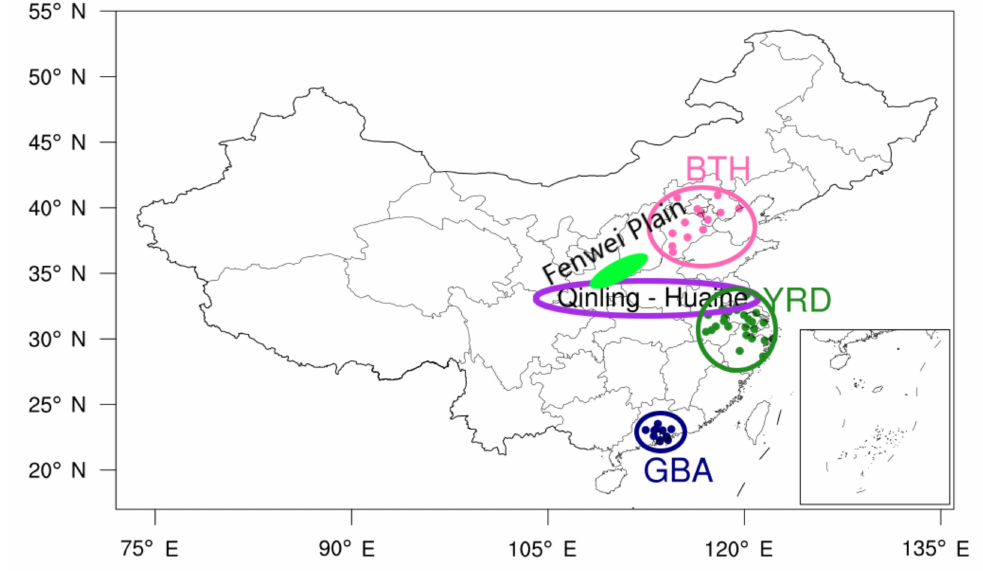
Figure 3. Map of the three major metropolitan agglomerations, the Fenwei Plain, and the Qinling Mountains-Huaihe River. The red, green and blue dots denote Beijing-Tianjin-Hebei (BTH), Yangtze River Delta (YRD) and Greater Bay Area (GBA) metropolitan agglomerations, respectively. The green filled area represents the approximate location of Fenwei Plain. The region within the purple ellipse indicates the general location of Qinling Mountains-Huaihe